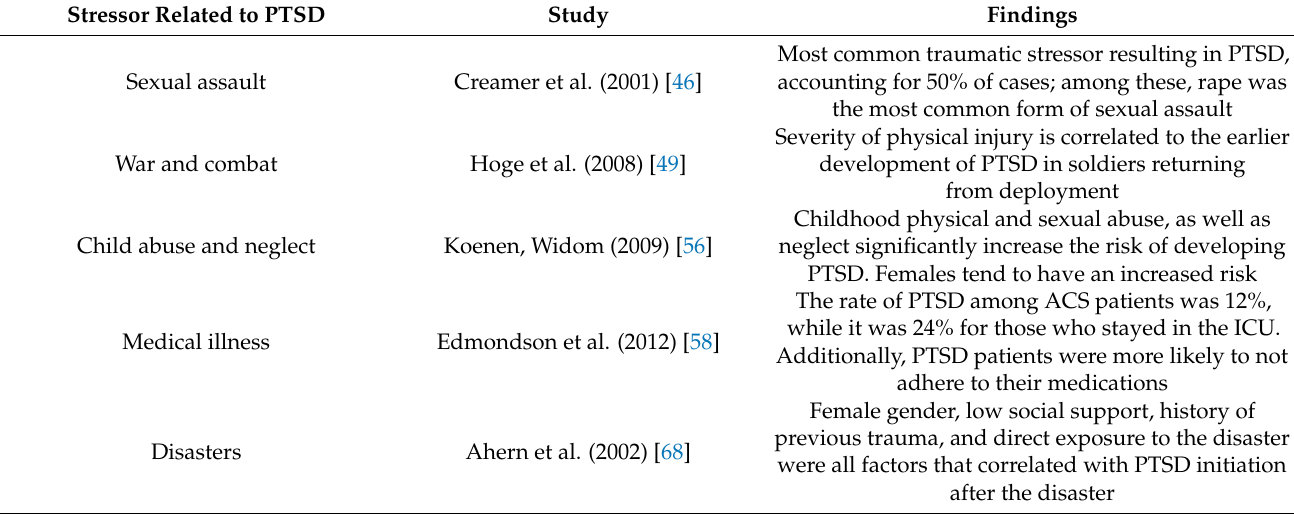
Table 1. Main types of stressors related to